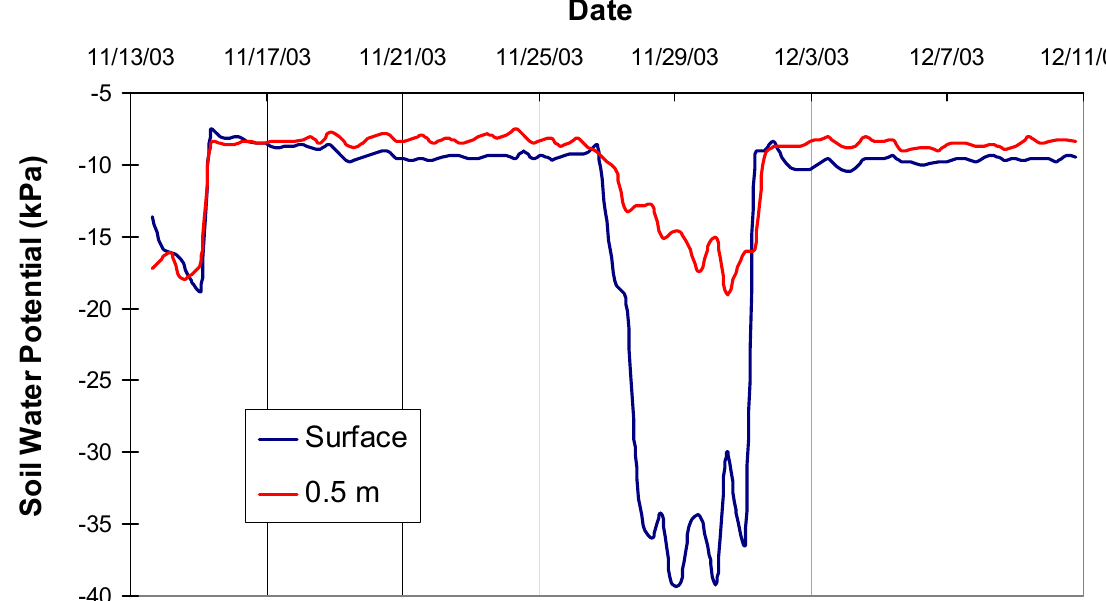
Figure 10. Comparison of pod 6 soil water potential at two